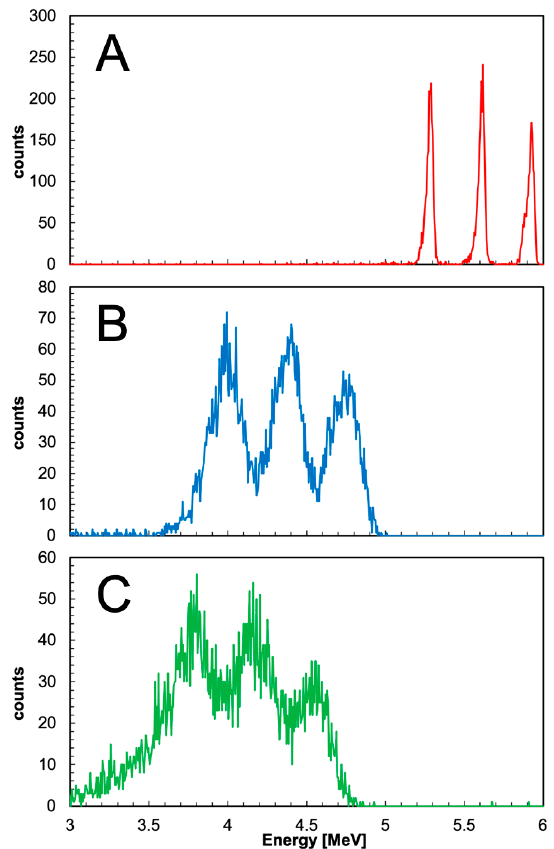
Figure 5. The alpha particle energy spectra recorded at each thickness measurement step. ( A ) no material between source and detector. ( B ) aluminum layer (6 µm nominal) between source and material between source and detector. ( B ) aluminum layer (6 µ m nominal) between source and detector. ( C ) 6 LiF and aluminum layers (1.8 µm and 6 µm nominal, respectively). See also Table 1.